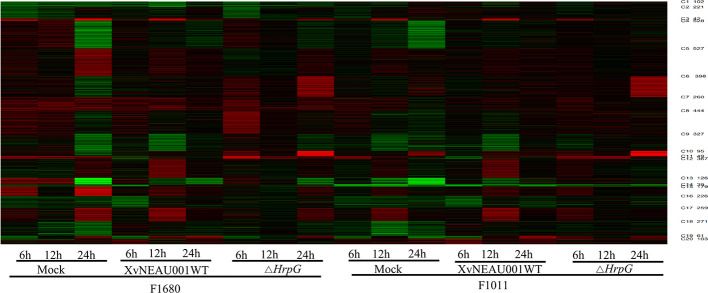
Weighted gene co-expression network analysis (WGCNA) based on the gene expression patterns of Sunong14, F1011, and F1680. (A) Hierarchical cluster tree with co-expression modules identified by the WGCNA. Each leaf in the tree represents one gene. The major tree branches constitute 40 modules labeled with different colors. (B) Module–sample association. Each row corresponds to a module labeled with a color as in (A). Modules are distinguished by different colors, which were arbitrarily assigned by the WGCNA package. Each column corresponds to a tissue type. The color of each cell at the row–column intersection indicates the correlation coefficient (R) between the module and the tissue type.